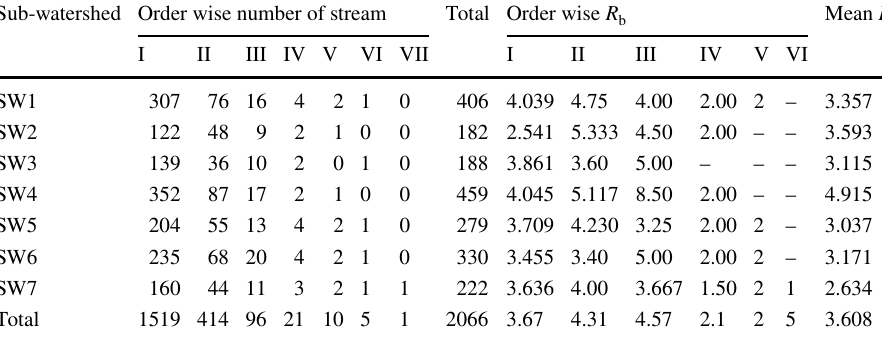
Table 2 Sub-watershed wise stream Numbers and bifurcation ratio ( R b